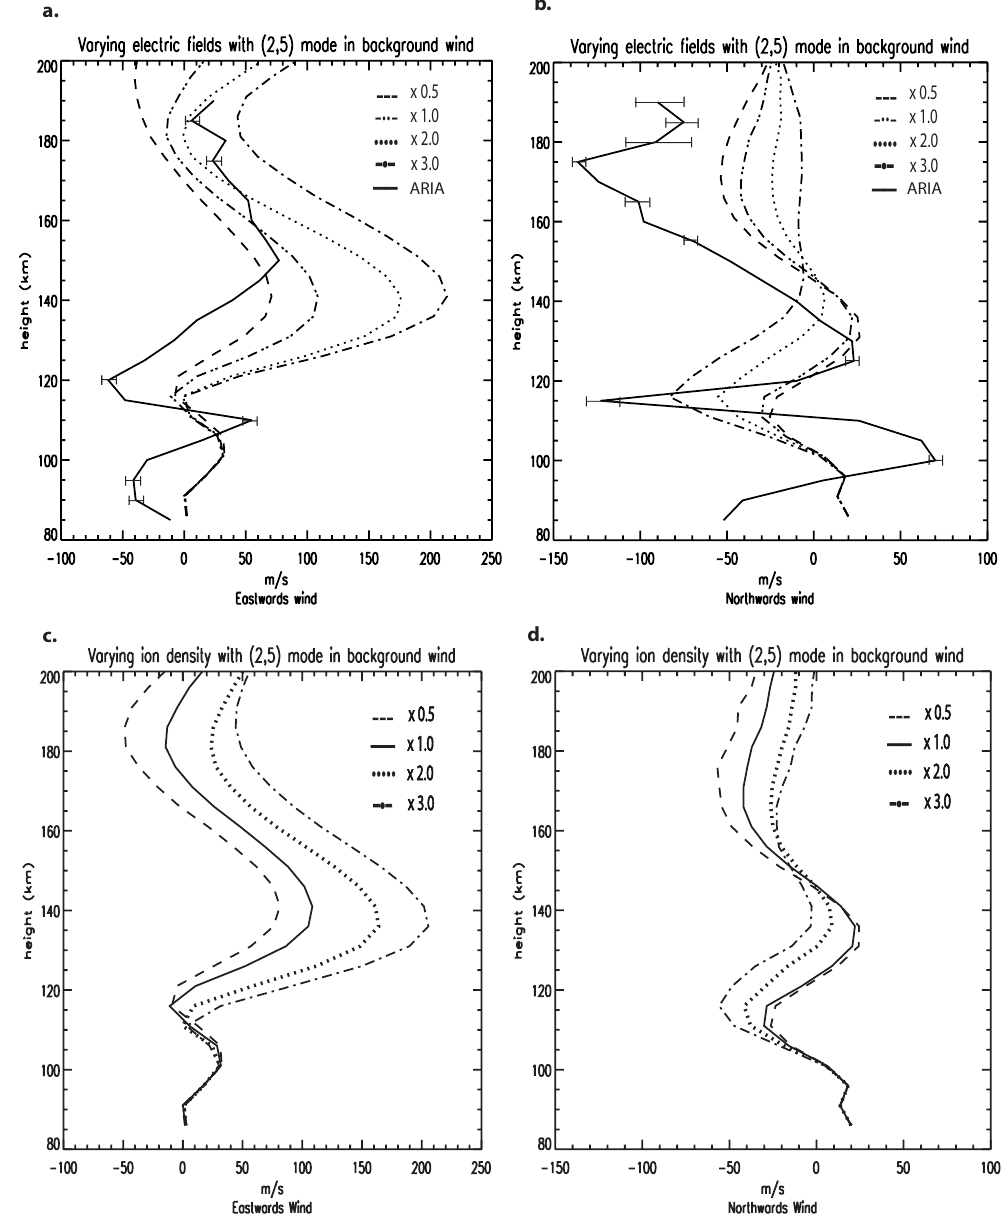
Fig. 5. (a) , (b) Response of the neutral winds to varying electric field magnitude, with (2,5) tidal mode in the background winds. The ARIA I observations are included for comparison. (c) , (d) Response of neutral wind to varying ion density enhancement, with (2,5) tidal mode in the background